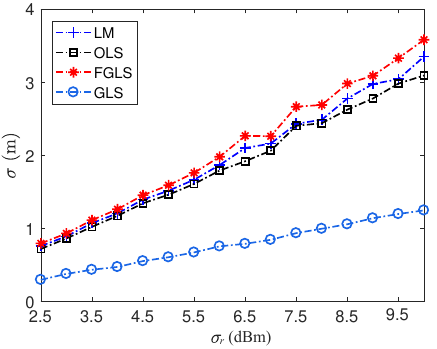
Fig. 6 Effects of error with estimated ˇˇˇ